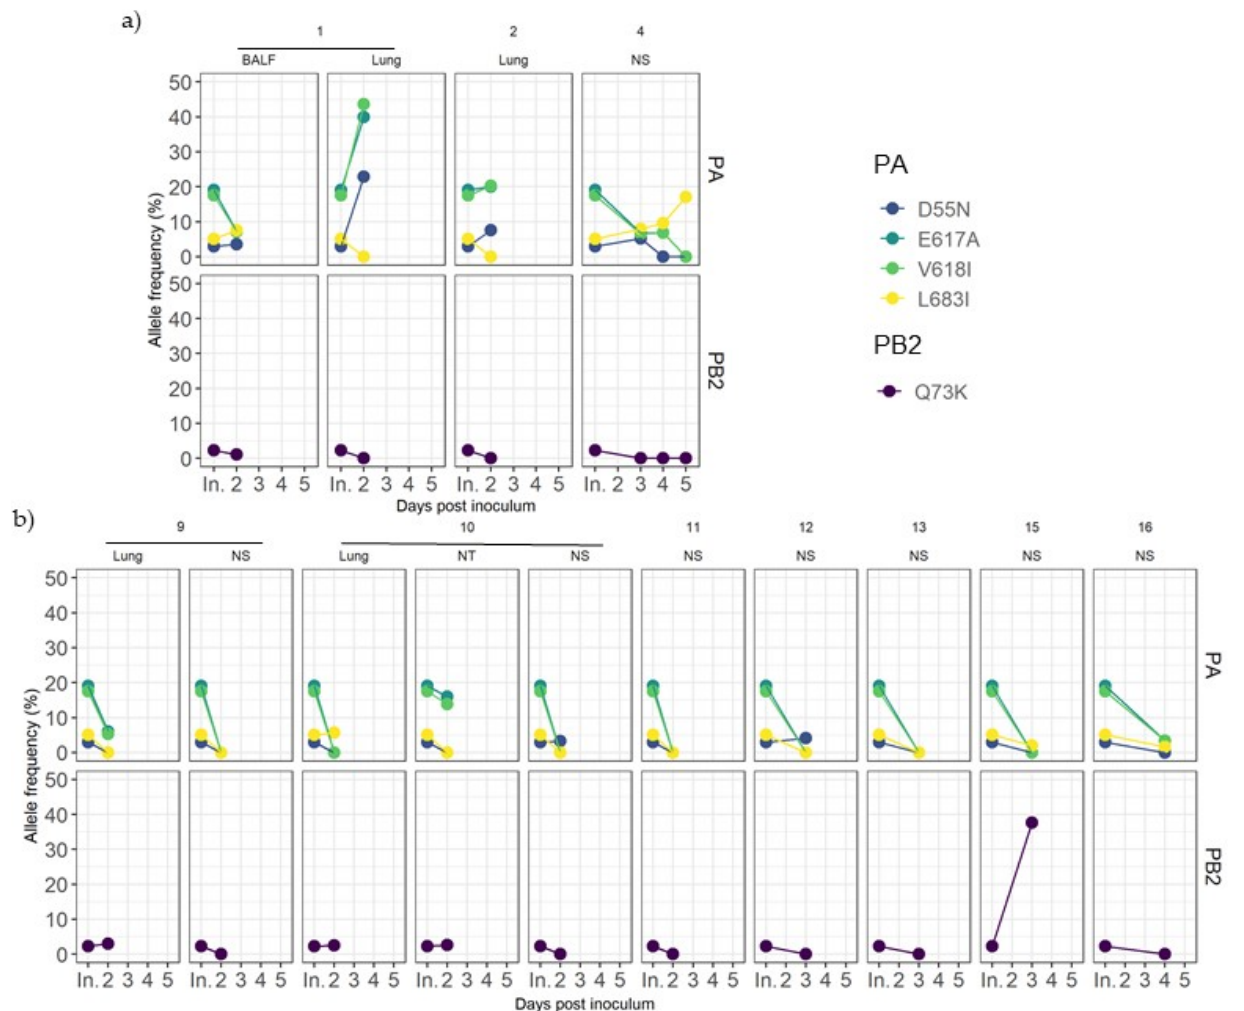
Figure 5. Dynamics of inoculum variant frequencies over time. ( a ) Samples from vaccinated animals. ( b ) Samples from nonvaccinated animals. Rows indicate genomic segments PA and PB2. Columns correspond to each animal and sample origin. X axes correspond to post ‐ inoculation time in which each sample was recovered, where “In.” indicates the inoculum. Y axes show the allele frequency. Each substitution is plotted in a different color.